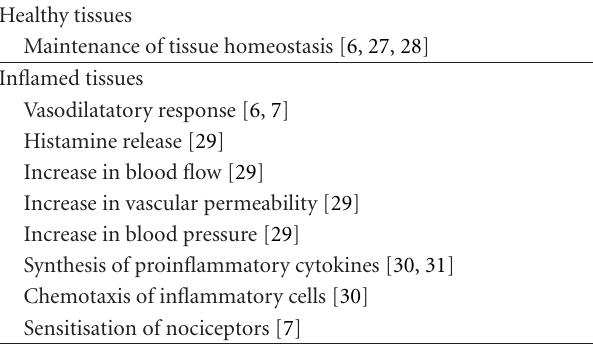
Table 1: Key e ff ects of substance P in dental